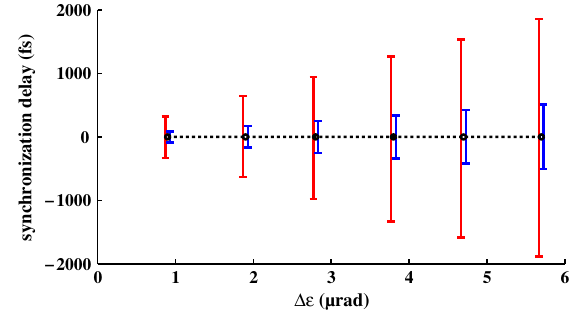
FIG. 14. Statistical distribution of the synchronization delay induced by MPS misalignment with 5000 events per point. The points connected by a dashed line describe the average synchro- nization delay of the data with the MPS alignment procedure of Appendix B. The error bars on the left of each point represent the extreme events of the data and the error bars on the right of each point represent the rms.